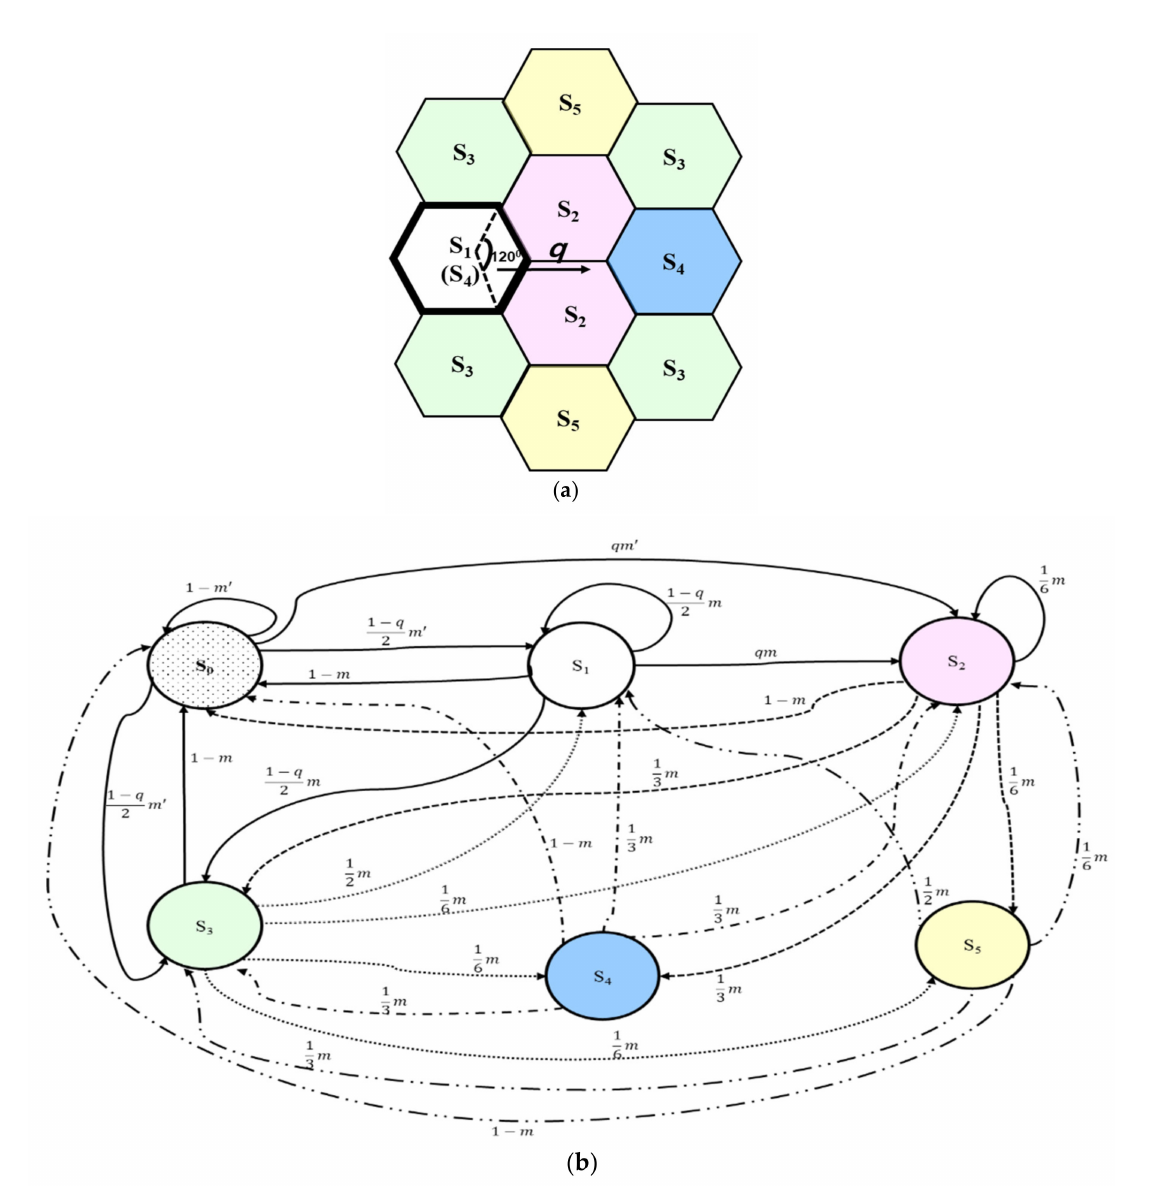
Figure 3. State transition diagram for rural environment (big sector, 120 ◦ ). ( a ) State of a big sector (120 ◦ ). ( b ) State transition diagram of a big